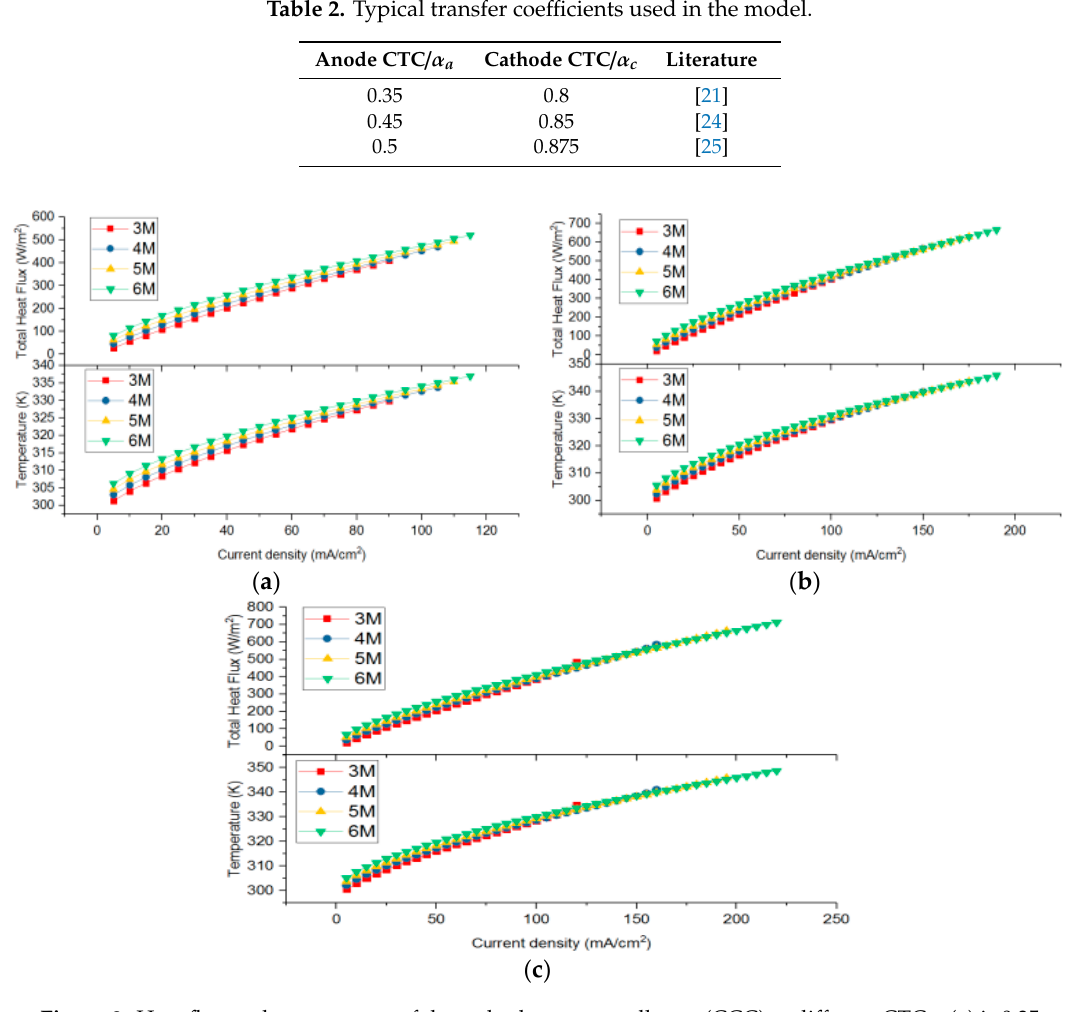
Figure 3. Heat flux and temperature of the cathode current collector (CCC) at different CTCs. ( a ) 𝛼 (cid:3028) is 0.35 and 𝛼 (cid:3030) is 0.8. ( b ) 𝛼 (cid:3028) is 0.45 and 𝛼 (cid:3030) is 0.85. ( c ) 𝛼 (cid:3028) is 0.5 and 𝛼 (cid:3030) is 0.875.